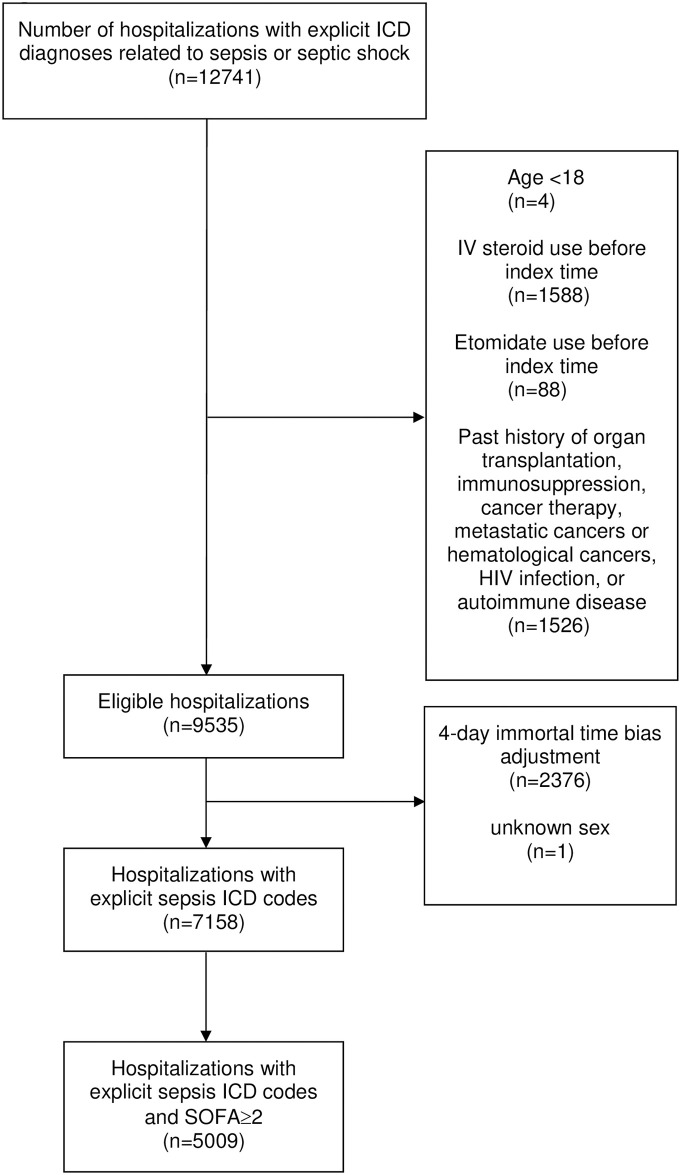
Cohort selection.